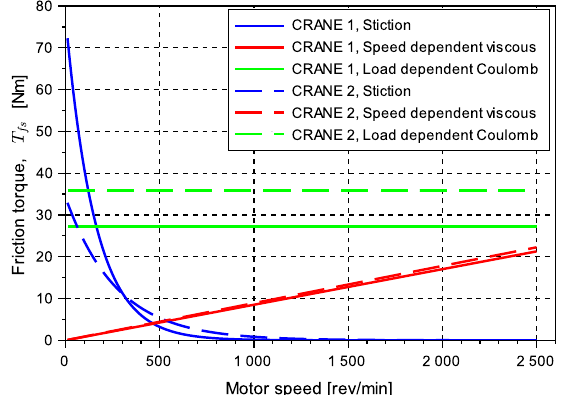
Figure 8: Comparison of modeled friction in Crane 1 and Crane 2. Crane load is 100